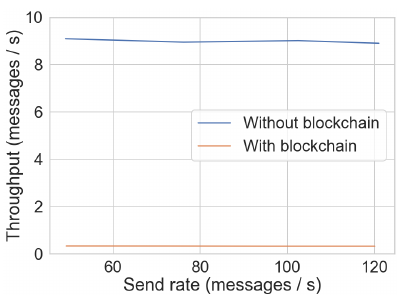
Figure 8. Throughput comparison depending on the send